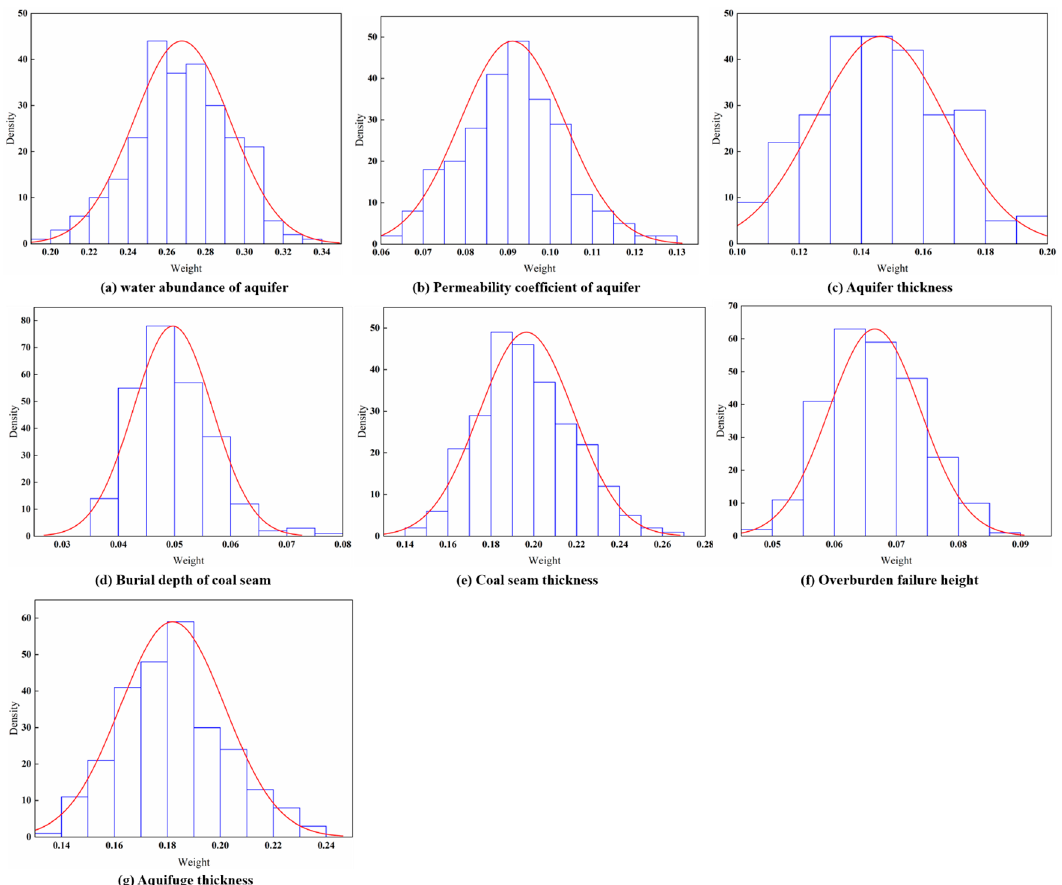
Figure 9. Evaluation criteria weight distribution function.